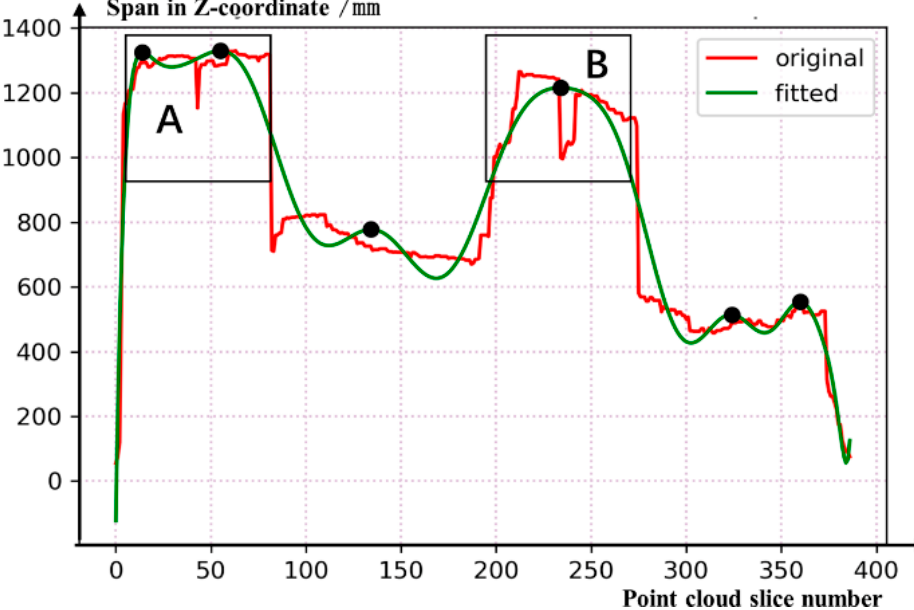
Figure 5. The distribution curve of span values with multiple extreme points. As Figure 5 shows, region A corresponds to the hind leg, and region B is assigned to the foreleg, and there are two extreme points in region A. When the beef cattle are walking, their legs are spread apart, thereby leading to two or more extreme points in region A or B on the fitted curve. In this case, the approximate central point of the leg region cannot be simply identified by a single extreme point. The algorithm showing the central point extraction for the leg region is presented in Figure 6 by means of pseudocodes, where Pi is the extreme point on the fitted curve ( i = 0, 1, 2. . . ), T represents the point set including the extreme points in the leg region, E is the point set excluding the extreme points in the leg region, Pm refers to any point in the set E , D is the point set made up of an extreme point and its surrounding extreme points, Pi.x is the x -coordinate value of a point, Pi.y is the y -coordinate value of a point, span y max is the span value of the range domain for the fitted curve, x max is the span value of the domain of the fitted curve, and X 1 and X 2 represent the x -coordinate values of the approximate midpoint in the leg region. In this process, the extreme points with similar x -coordinate values are merged, and meanwhile, the merged extreme points need to be located on both sides of the central point of the abdomen, which can ensure that two core points belonging to the leg region are successfully extracted, representing the x -coordinate positions of the fitted curve for the regions of the forelegs and hind leg. The y -coordinate positions of the approximate midpoint in the leg region are therefore